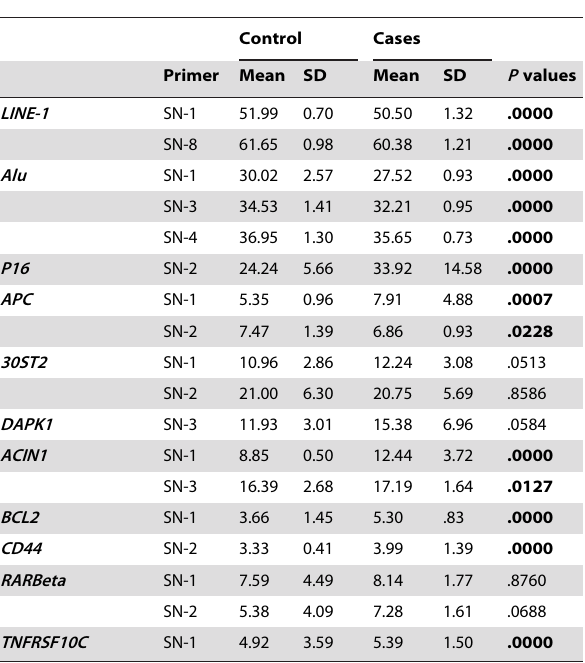
Table 2. Peripheral blood derived DNA mean methylation comparison in cases and controls (Mann-Whitney